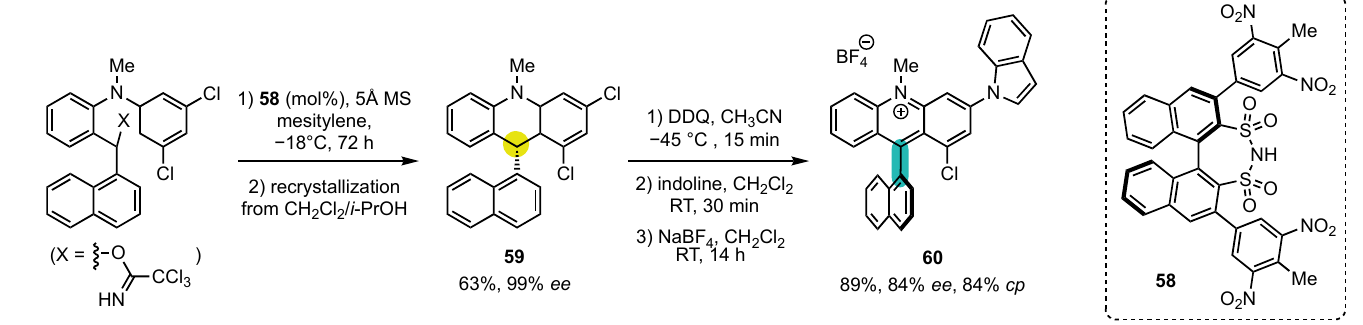
Scheme 16. Enantioselective synthesis of atropisomeric 9 ‐ arylacridinium salts.